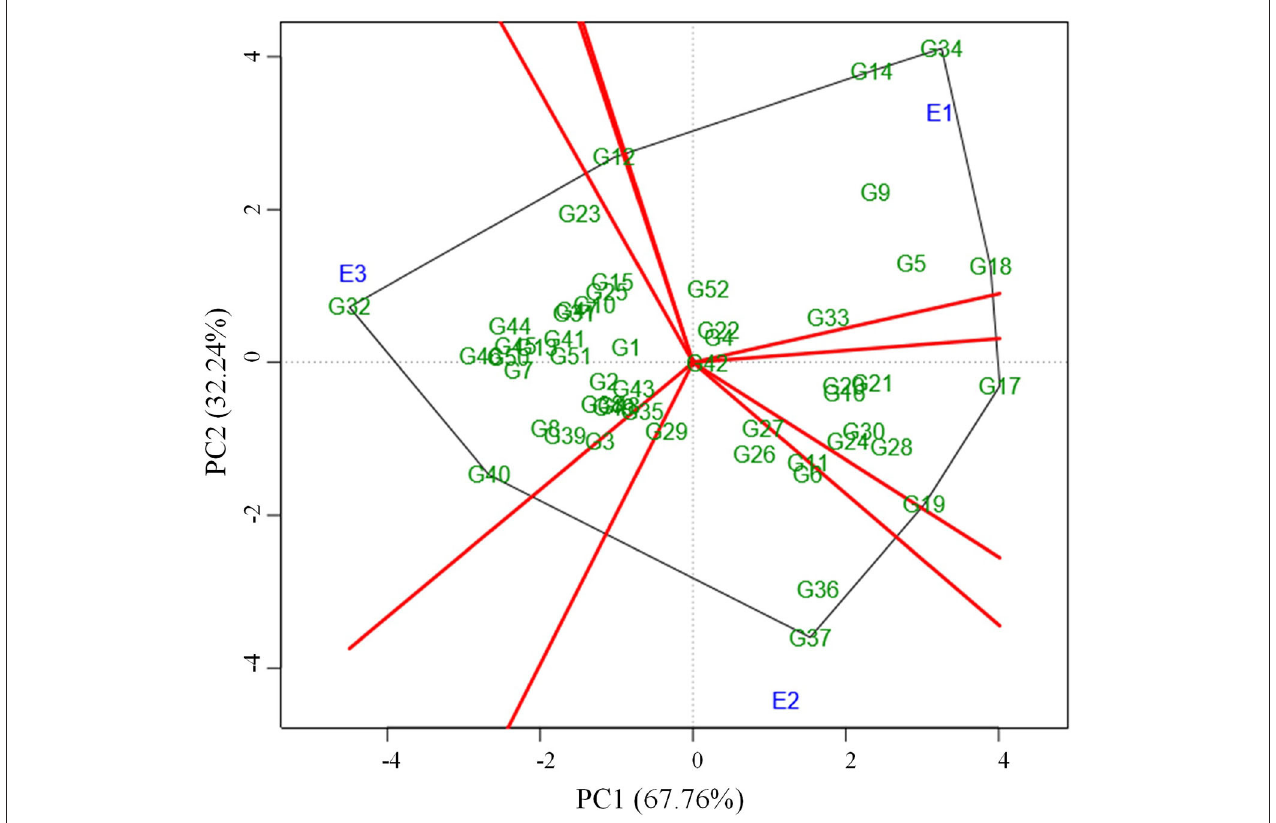
FIGURE 3 | Which-won-where pattern of 52 genotypes and three environments based on symmetrical scaling showing winning genotype in each environment.